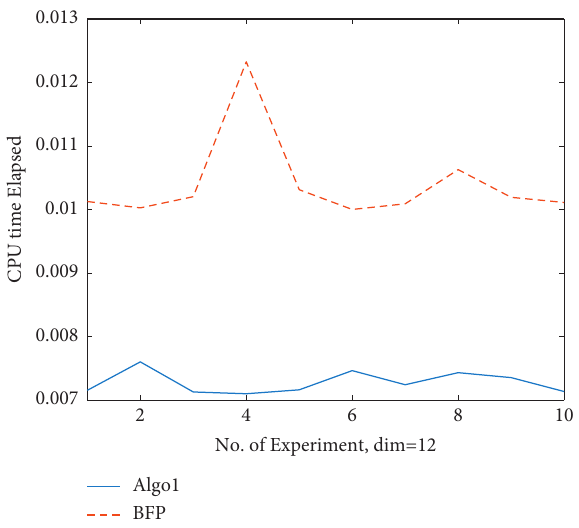
Figure 14: CPU time vs no of iteration for dimension 12.